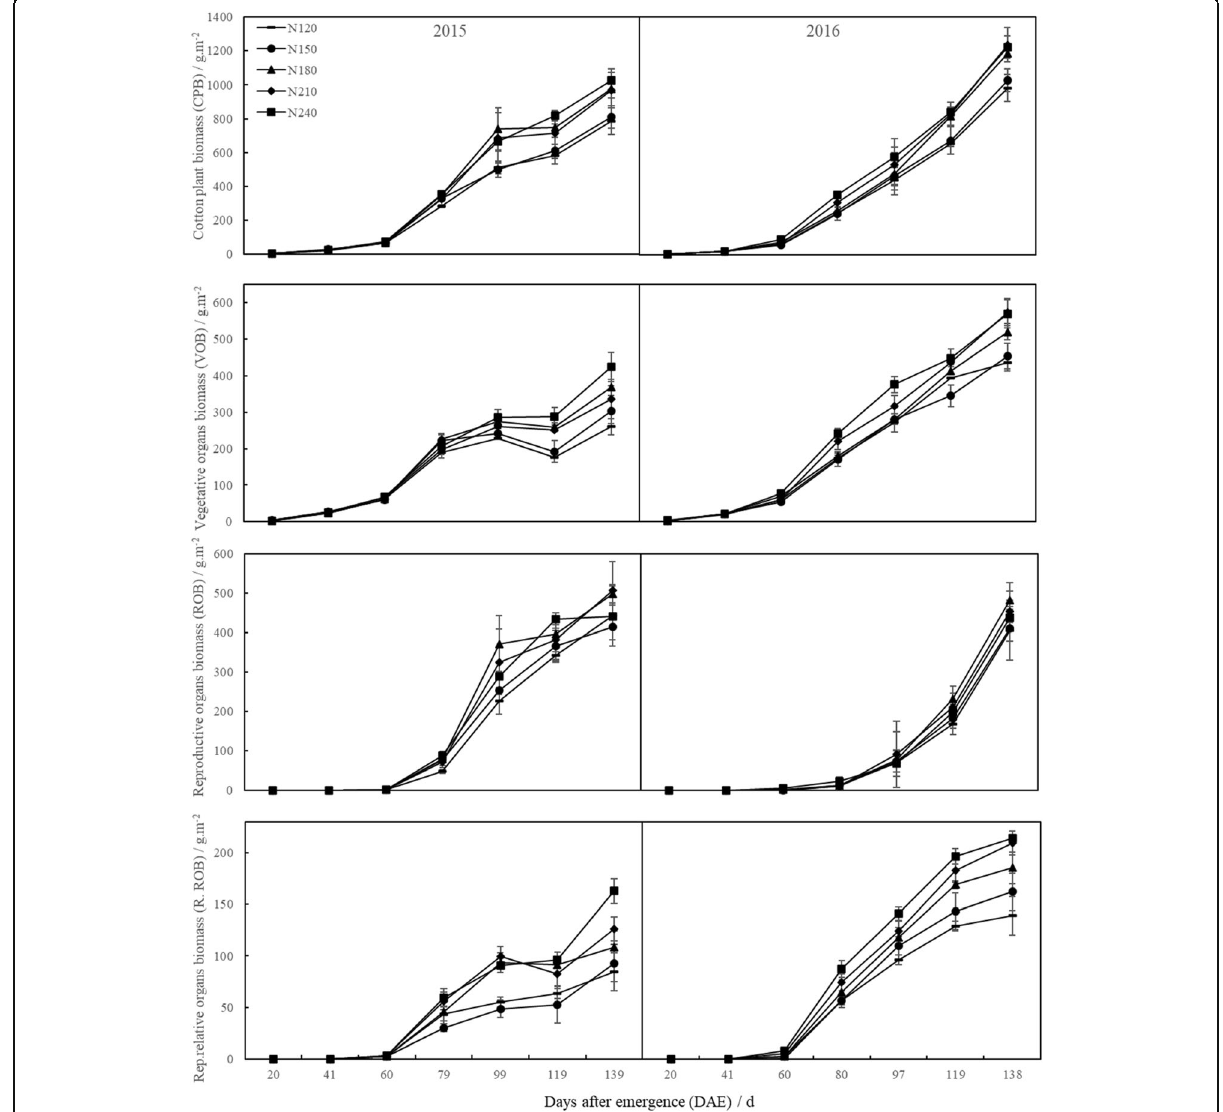
Fig. 3 Effect of different N rates on cotton plant biomass (CPB), vegetative organ biomass (VOB), reproductive organ biomass (ROB) and reproductive relative organ biomass (R. ROB) accumulation in 2015 and 2016. Error bar shows SE of